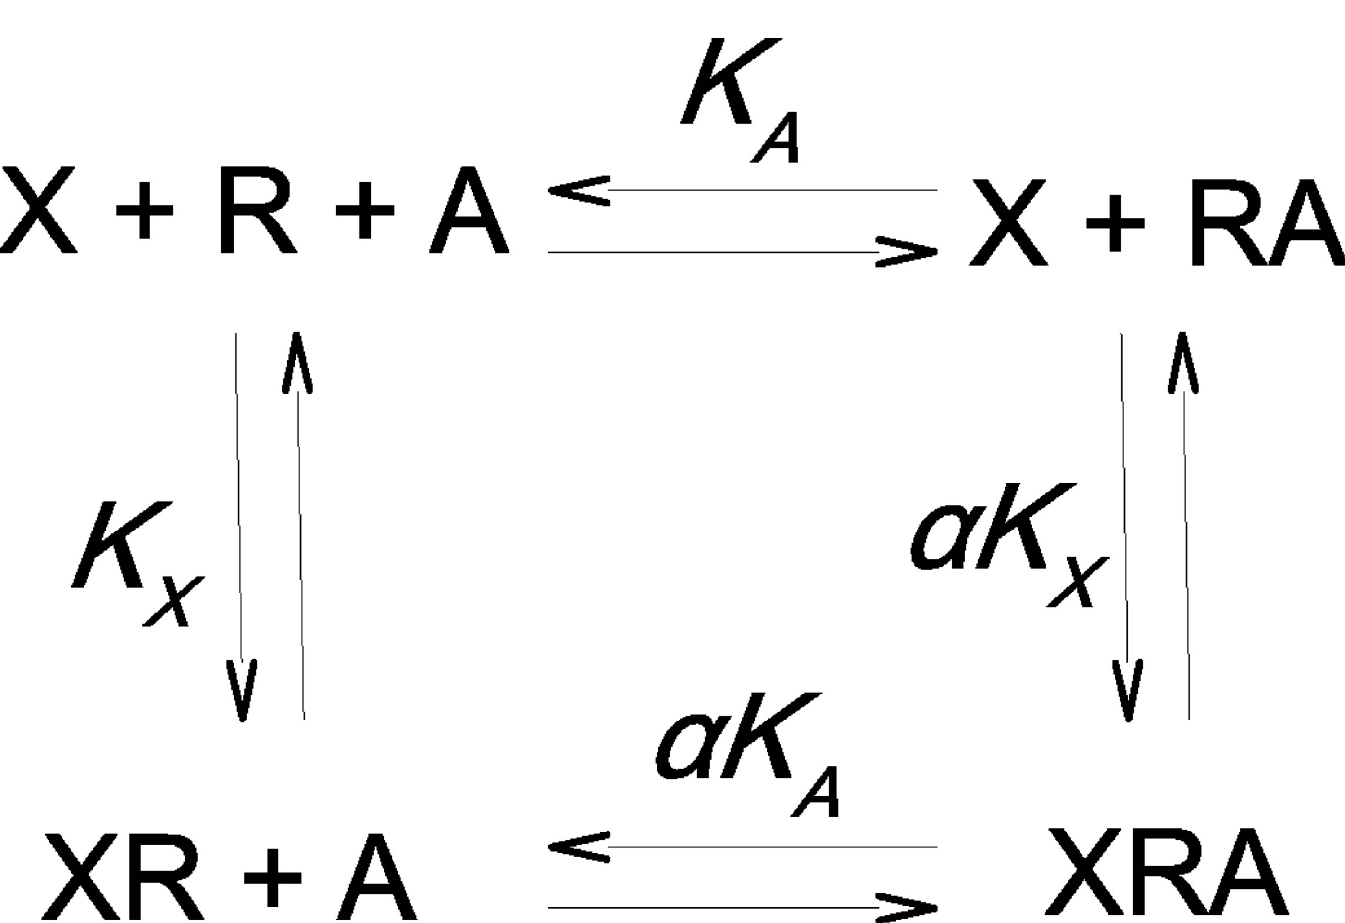
Fig 1. Ternary complex model. Allosteric interaction between tracer X and allosteric modulator A at receptor R. K X is the equilibrium dissociation constant of tracer X in the absence of A, K A is the equilibrium dissociation constant of allosteric modulator A in the absence of X and α is the factor of binding cooperativity between tracer and allosteric modulator.